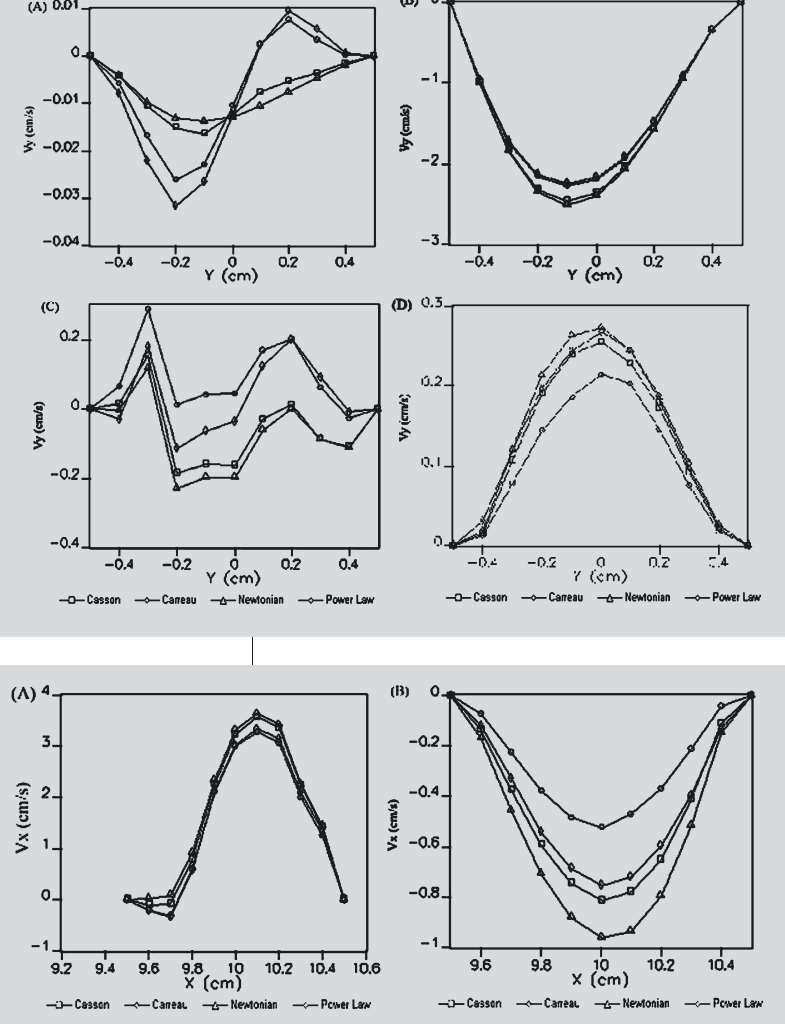
Figure 5 (left above): Radial component velocity profiles in the main tube along different lines: (A) line L1, (B) line L2, (C) line L3, and (D) line L4. Figure 6 (left below): Radial component velocity profiles in the side tube along different lines: (A) line L5 and (B) line L6. Figure 7 (right): Flow recirculation zones showing variation in vortex size as predicted by: (A) Car- reau model, (B) power law model (C) Casson model, and (D) Newtonian